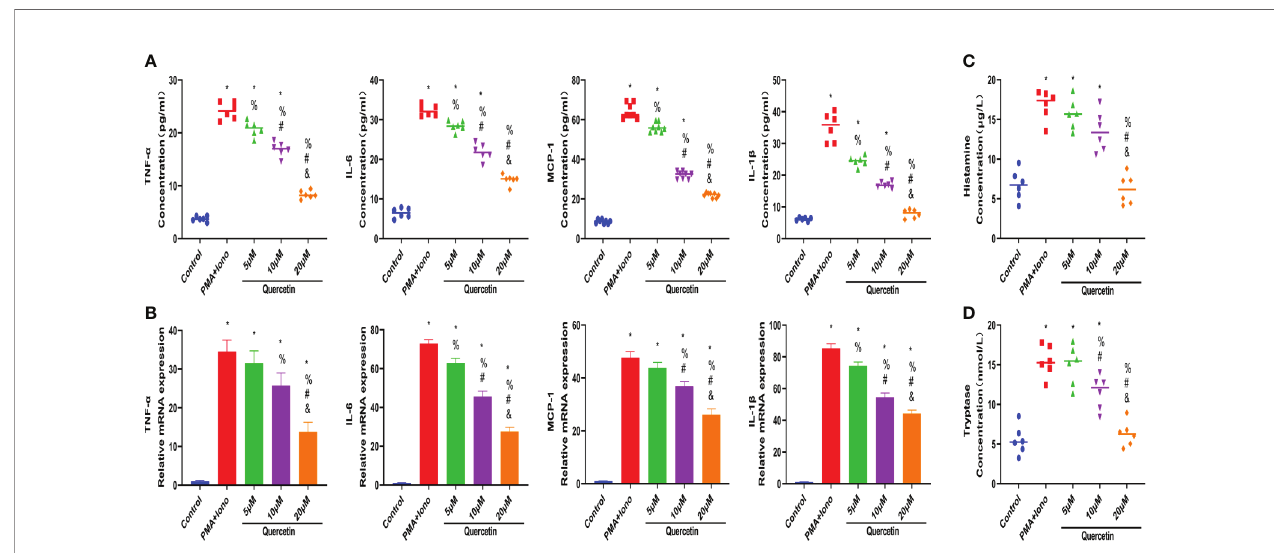
FIGURE 6 | Quercetin disabled mast cell secretion of proin fl ammatory cytokines in vitro . P815 cells were pretreated with quercetin for 1 h and then incubated with PMA and ionomycin for 24 h. (A) In fl ammatory cytokine secretion of P815 cells was examined by ELISA. P815 cells were pretreated with quercetin for 1 h and then incubated with PMA and ionomycin for 8 h. (B) Relative gene expression of in fl ammatory cytokines in P815 cells as evaluated by qRT-PCR. (C) Histamine release from P815 cells was evaluated by ELISA. (D) Tryptase release from P815 cells as evaluated by ELISA. *P < 0.05 compared with the control group, % P < 0.05 compared with the PMA+Iono group, # P < 0.05 compared with the 5 m M group, & P < 0.05 compared with the 10 m M